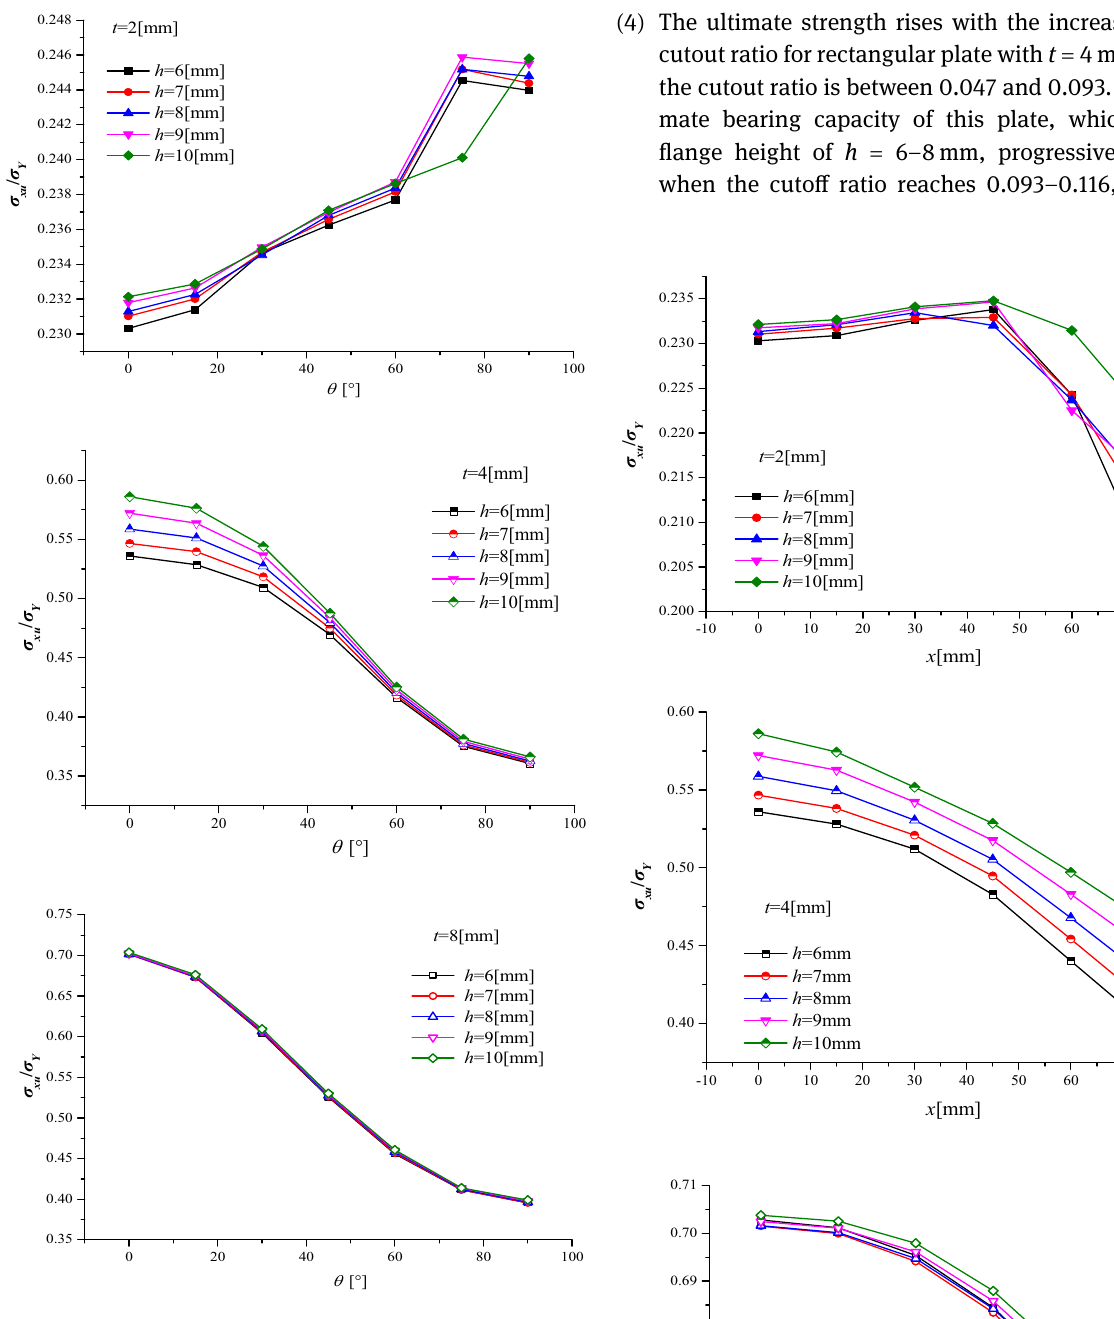
Figure 6: In fl uence of cutout rotation angle on ultimate strength.